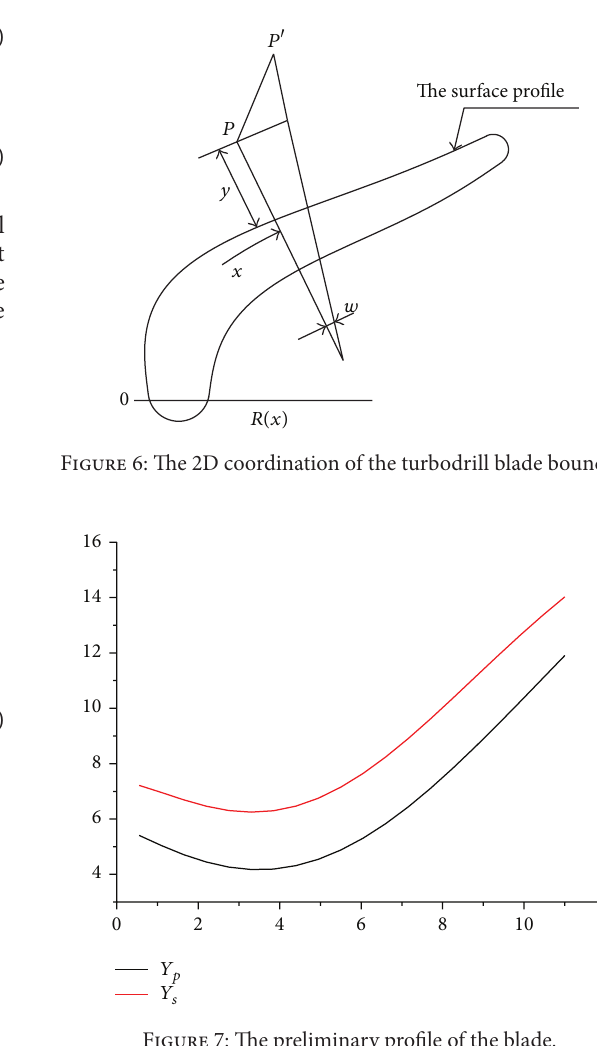
The parameters of 𝑎 0 , 𝑎 1 , 𝑎 2 , 𝑎 3 , 𝑎 4 , 𝑎 5 , 𝑏 0 , 𝑏 1 , 𝑏 2 , 𝑏 3 , 𝑏 4 , and 𝑏 5 can be solved by the two linear equations (19) and